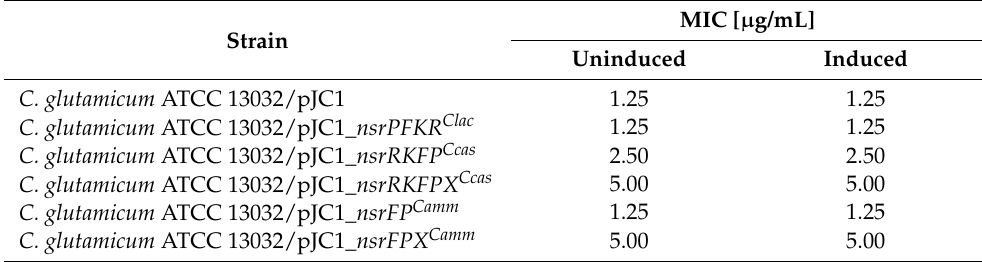
Table 4. Minimal inhibitory concentrations (MIC) of recombinant Corynebacterium glutamicum strains expressing different resistance loci determined in the experiments shown in Figure S9 with (induced) or without (uninduced) preincubation in medium containing sublethal concentrations of nisin.